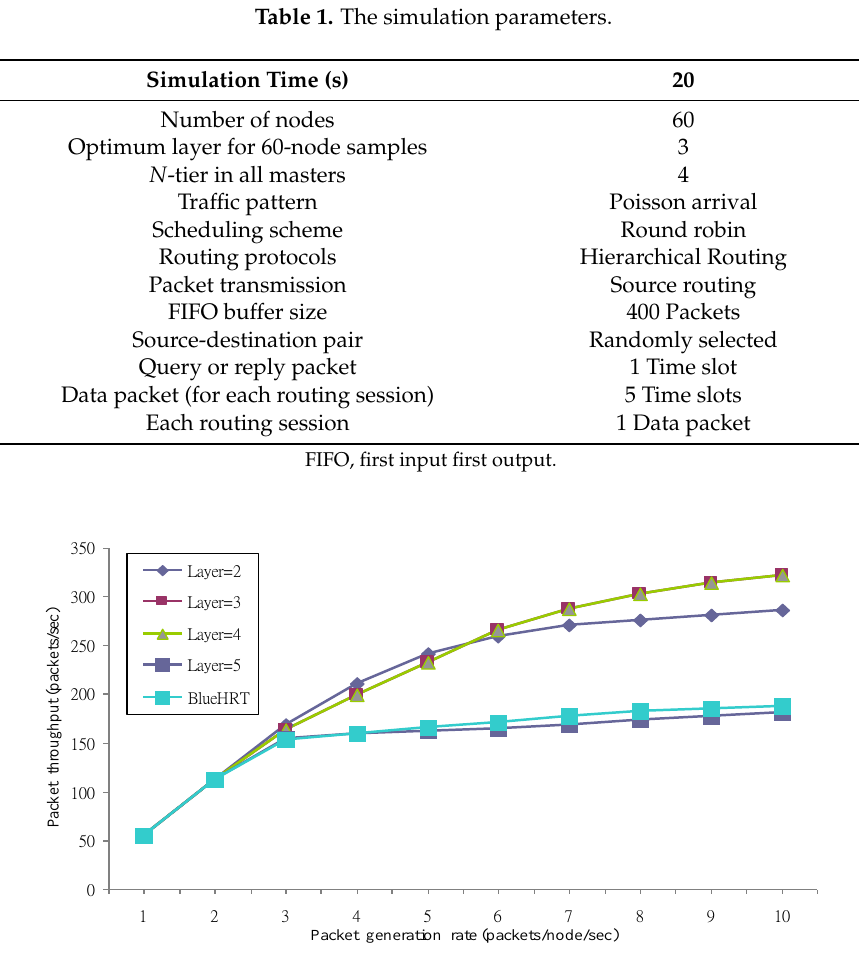
Table 1. The simulation parameters. Simulation Time (s) 20 Number of nodes